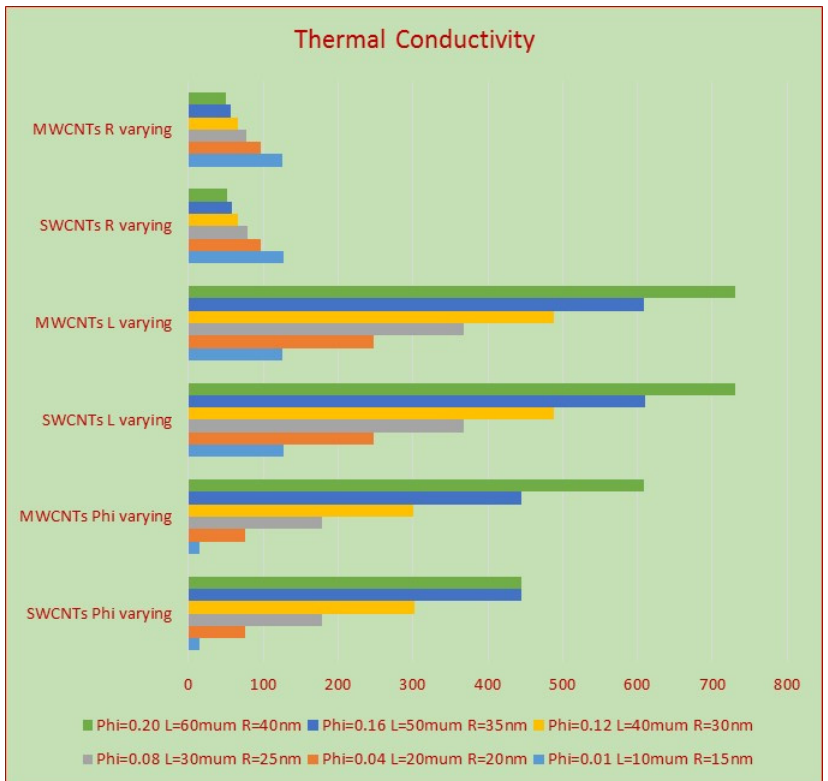
Figure 8. The behavior of thermal conductivity of SWCNTs and MWCNTs for multiple volume fraction factor ϕ .